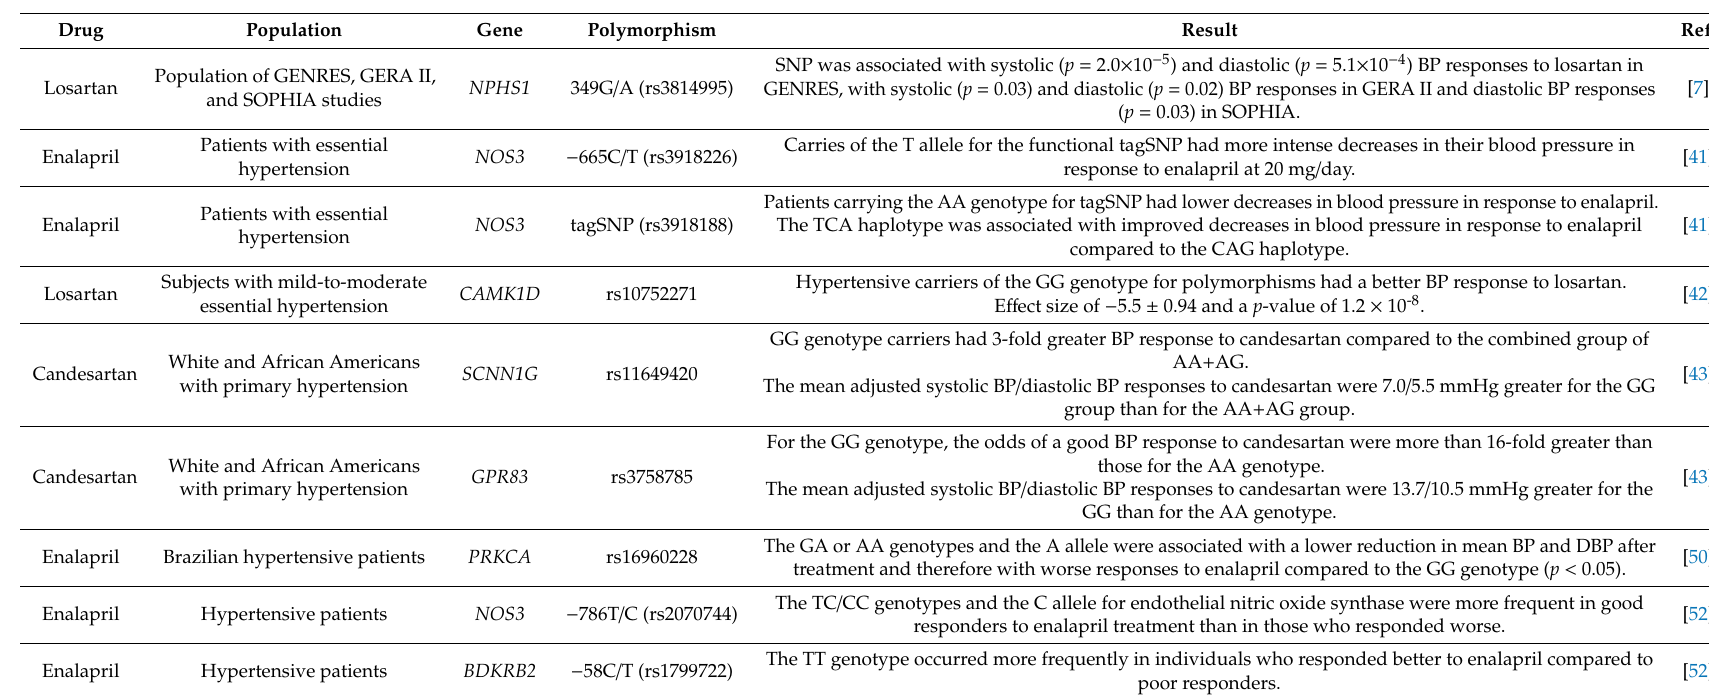
Table 2. A summary of the results of the most interesting studies on angiotensin-II receptor blockers and angiotensin-converting enzyme inhibitors presented in this